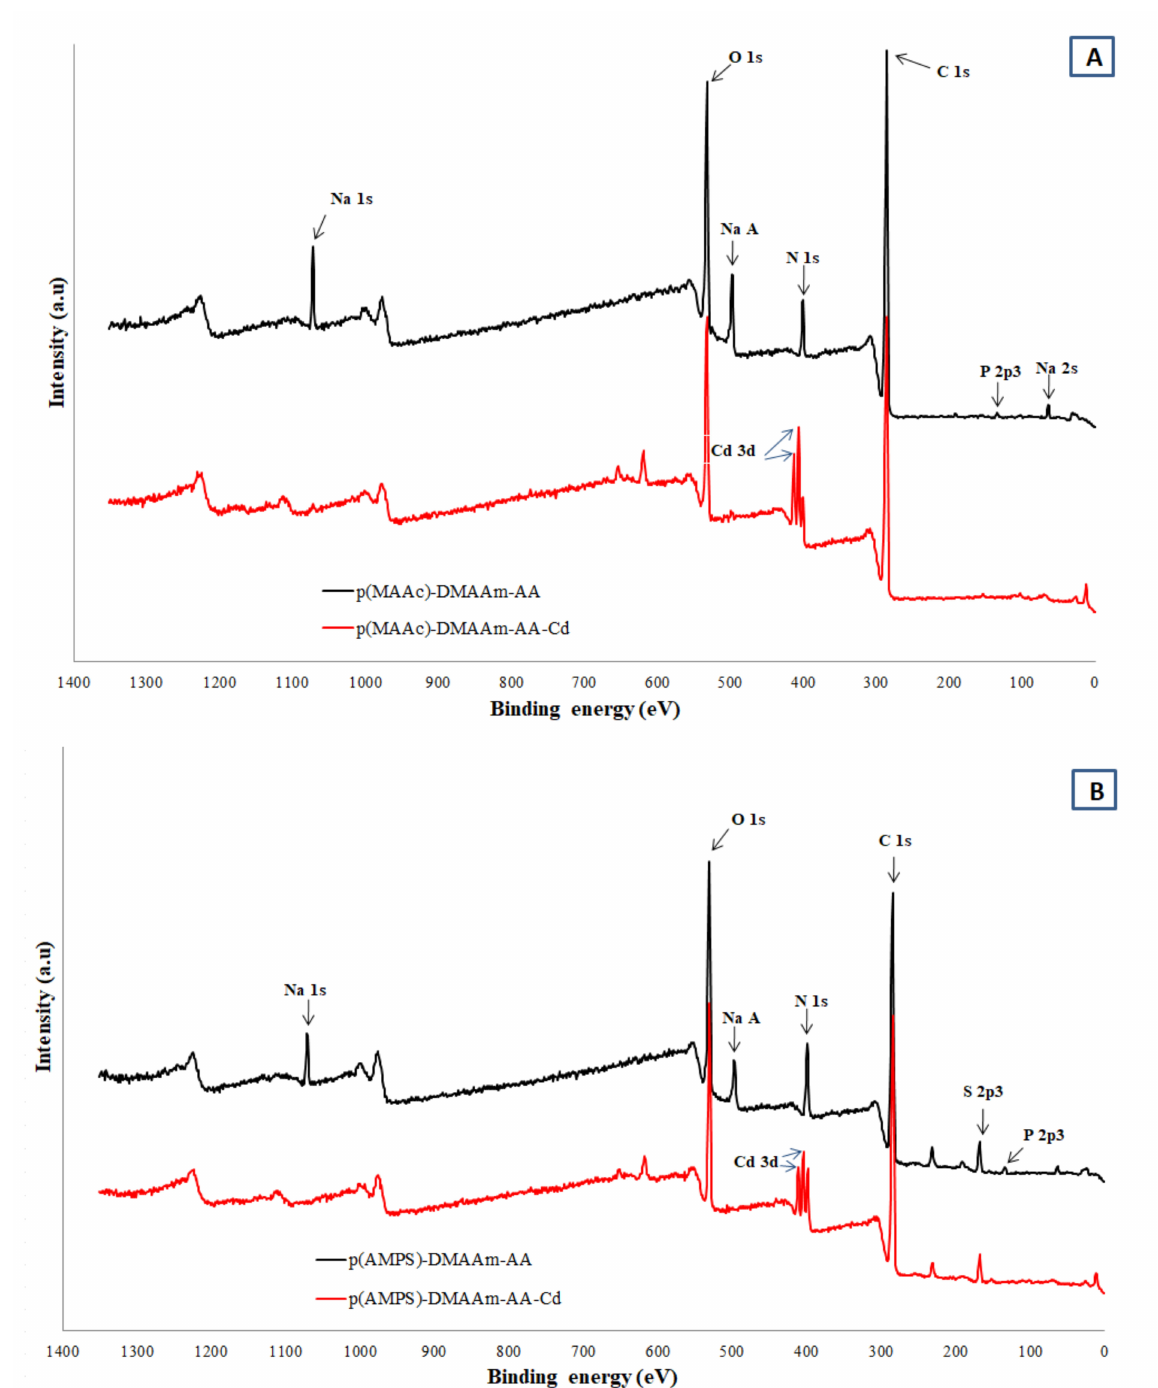
Figure 8. XPS patterns of cryogels before and after metal ions removal ( A ) p(MAAc)-DMAAm-AA ( B ) p(AMPS)-DMAAm-AA